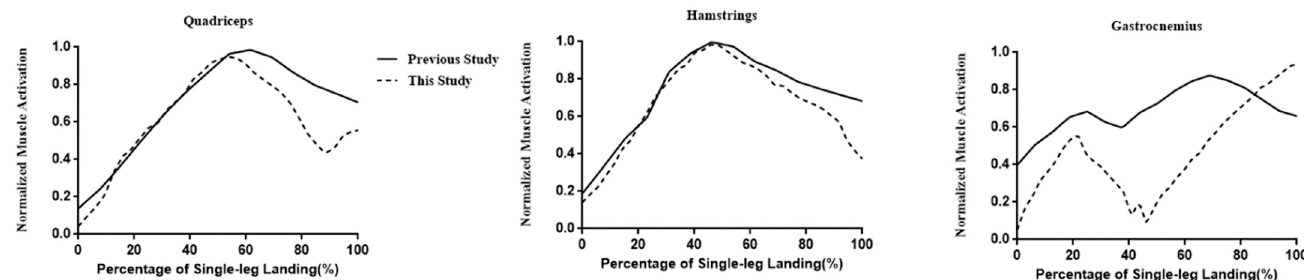
Figure 2. Comparisons between our simulation results and previous study data. At the peak GRF, no correlation between whether or not a knee brace was worn and the landing height was indicated by any of the lower limb muscle forces ( p > 0.05). The outcomes indicated significant differences ( p < 0.05) in the forces of the vastus medialis, vastus intermedius, vastus lateralis, medial gastrocnemius, lateral gastrocnemius, and soleus in the participants who were wearing a knee brace compared to those who were not wearing one. The gluteus maximus muscle was significantly affected at the height of 45 cm compared to 30 cm.